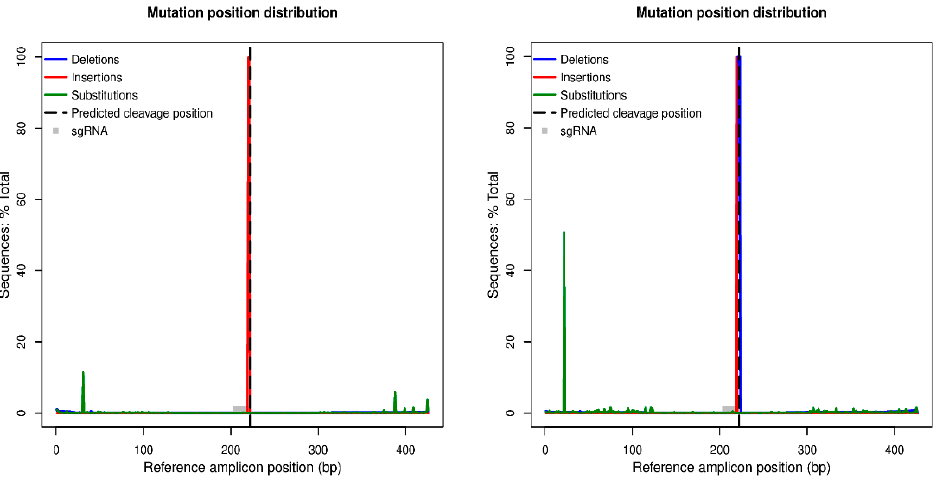
* PCR amplification results of Ti integration for p DIRECT22C: gRNAs vector are shown in Figure 3. ** PCR amplification and restriction results of the assay are shown in Figure 4.